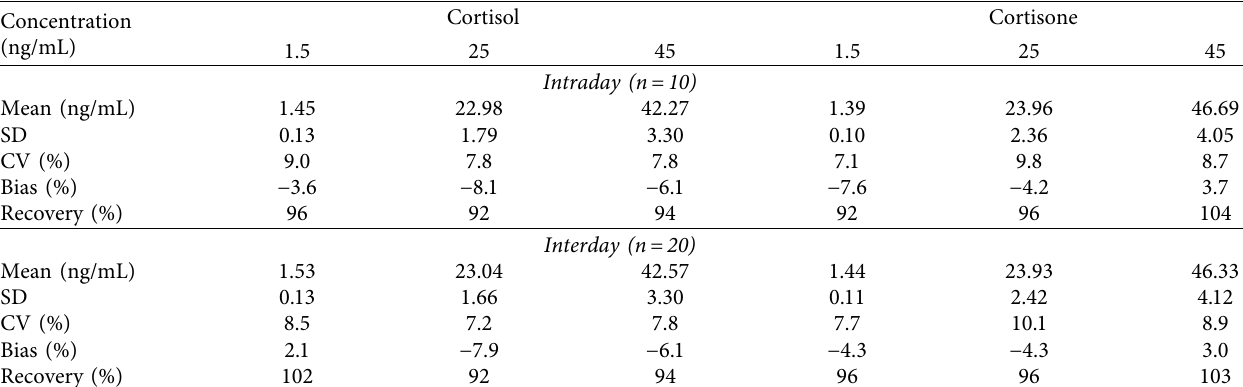
Table 1: Validation